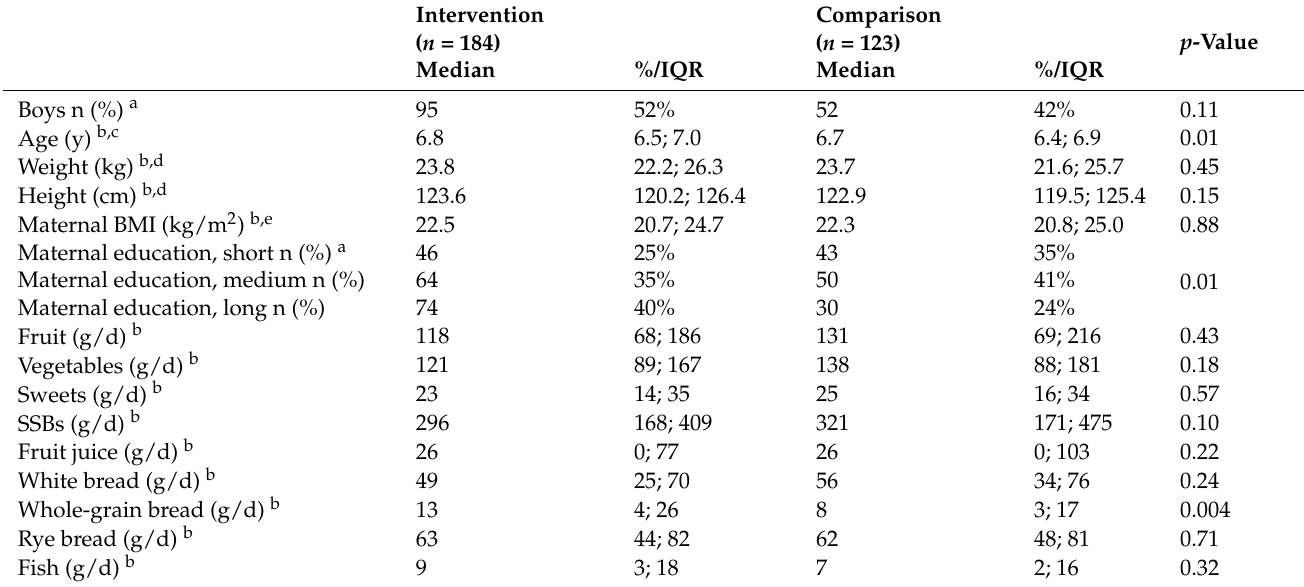
Table 1. Pre-intervention characteristics of the participants by intervention/comparison group.